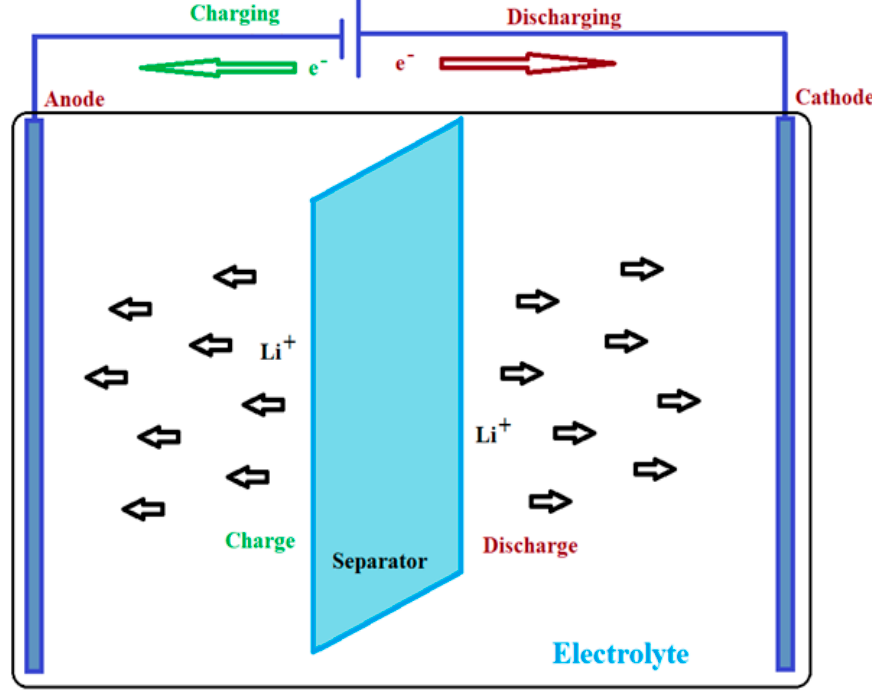
Figure 5. Typical Li-ion battery module.